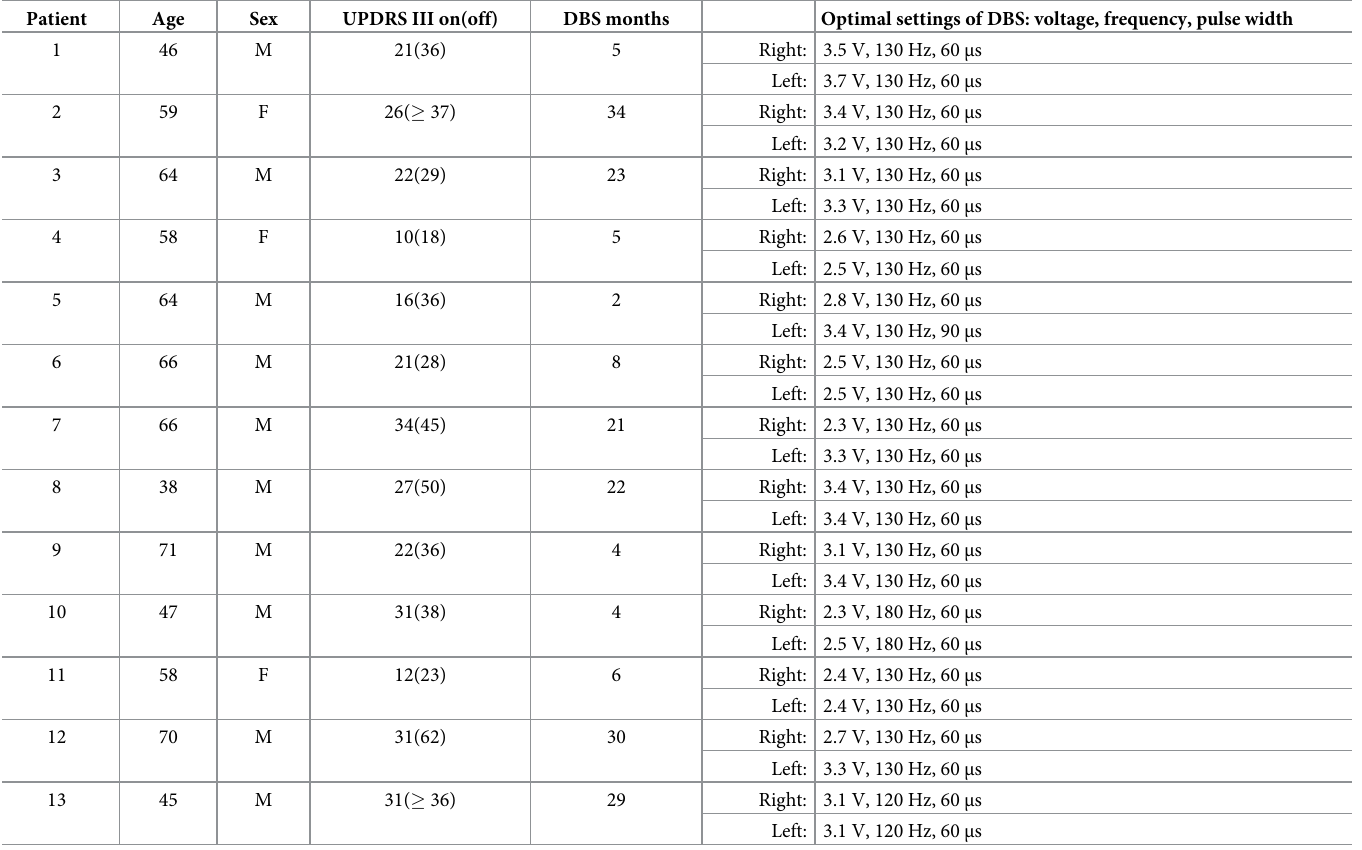
Table 1. Patients, UPDRS-III score, and DBS details. DBS months refer to number of months after DBS implantation. UPDRS-III assessment could not be completed on patients 2 and 13 due to side effects and notion � is